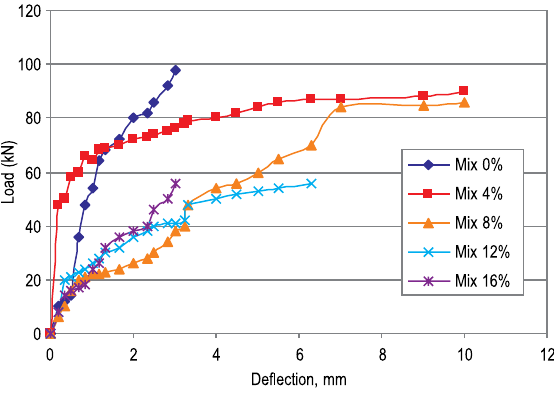
Fig. 7. Deflection of all